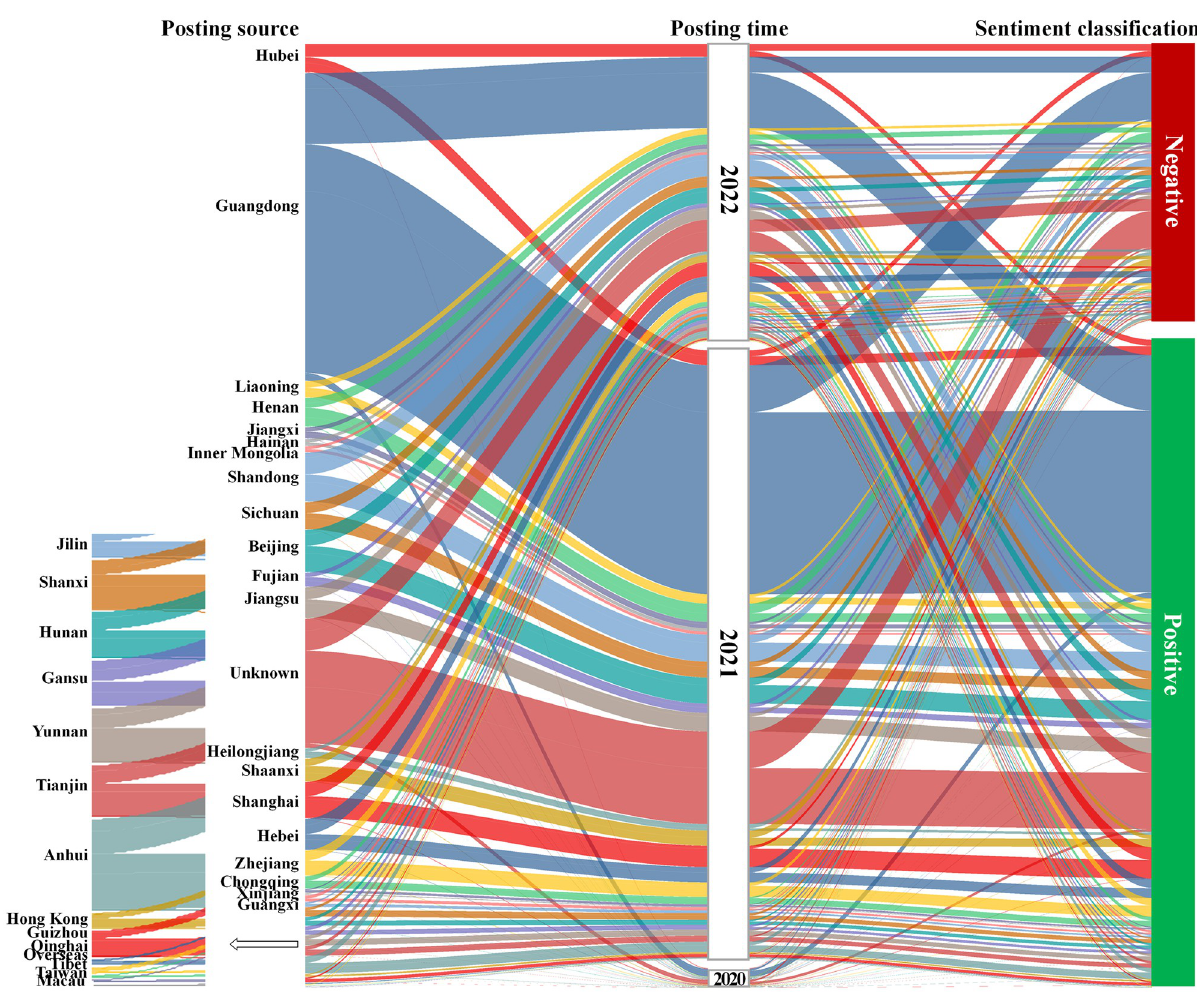
Fig 4. Sankey diagram of public comments characteristics on urban